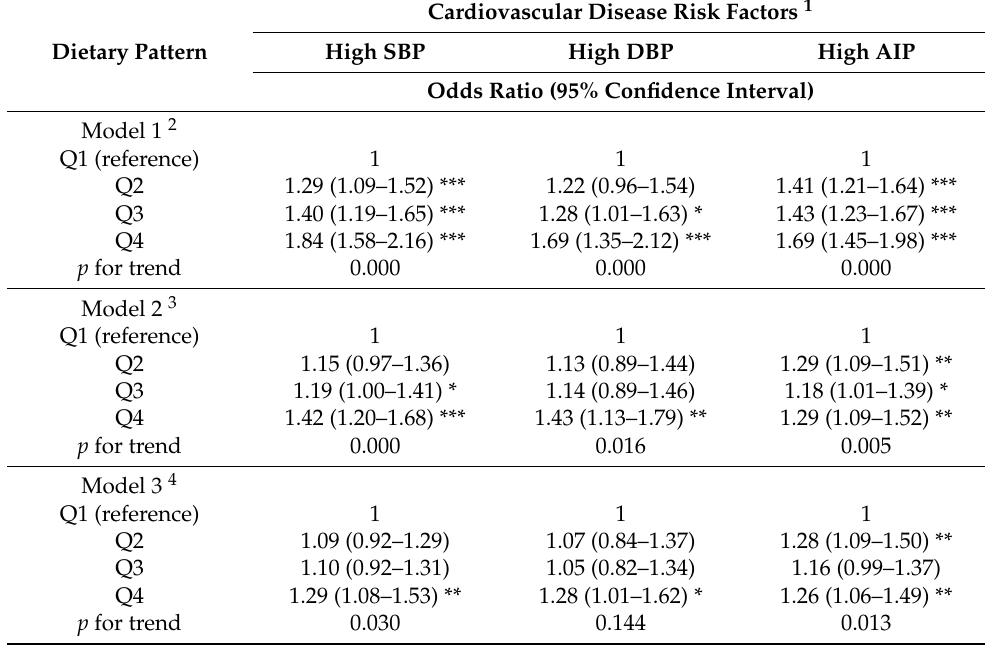
Table 3. Binary logistic regression for the association between the dietary pattern, systolic blood pressure (SBP), diastolic blood pressure (DBP), and atherogenic index of plasma (AIP) ( n = 5689).